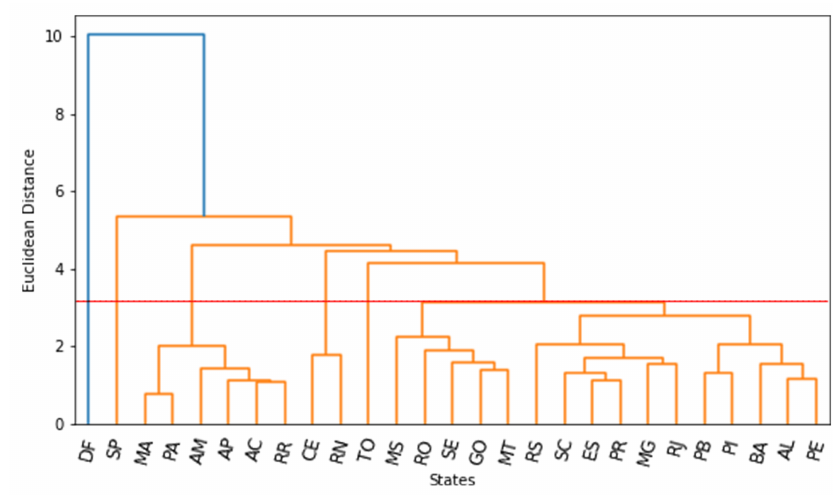
Figure 2. Dendrogram generated for the database with all age groups. The multivariate analysis technique was applied to the 2021 data, grouping Brazil in a different format from the Brazilian regions, which can be observed in the branches of the tree. It presents satisfactory CCC (0.887), and six clusters were suggested.